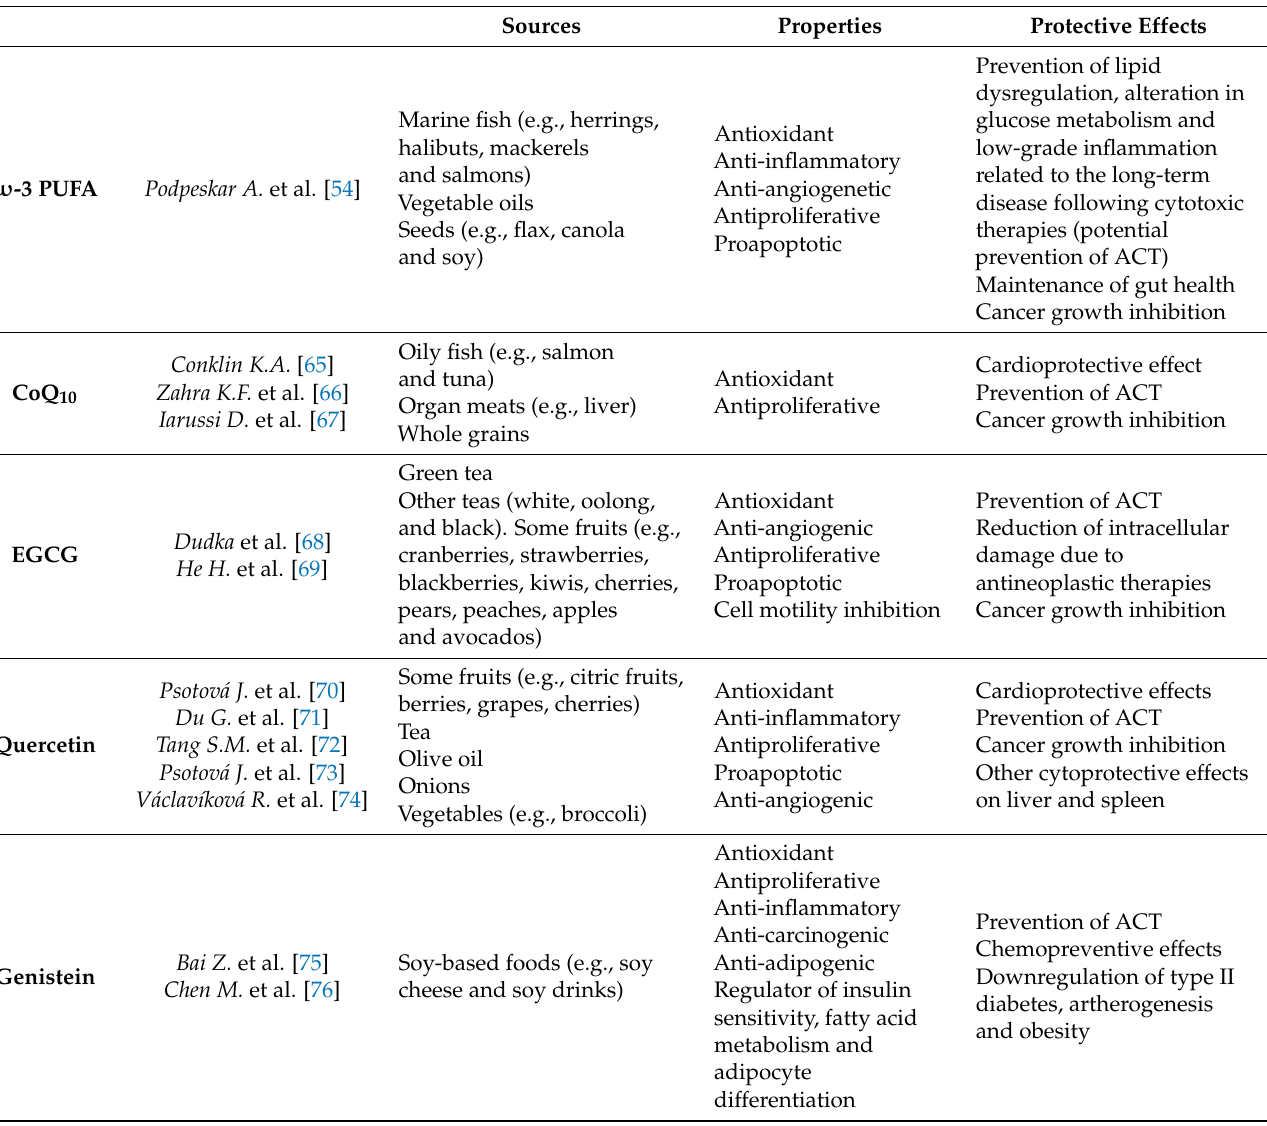
Table 1. List of nutrients with a potential role in primary prevention of cardiovascular damage in childhood cancer survivors, with their sources, properties and additional protective